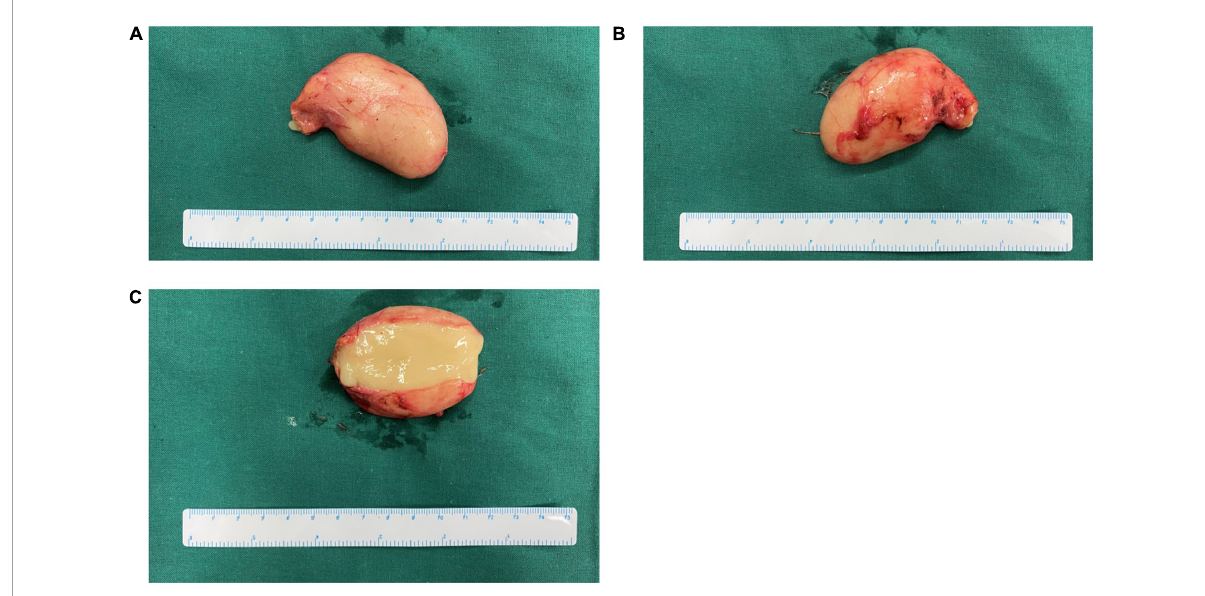
FIGURE2 Gross appearance of the cyst from case 18 in our series. (A,B) Gross appearance from two sides, respectively. (C) Cross-section of cyst showed yellowish gelatinous